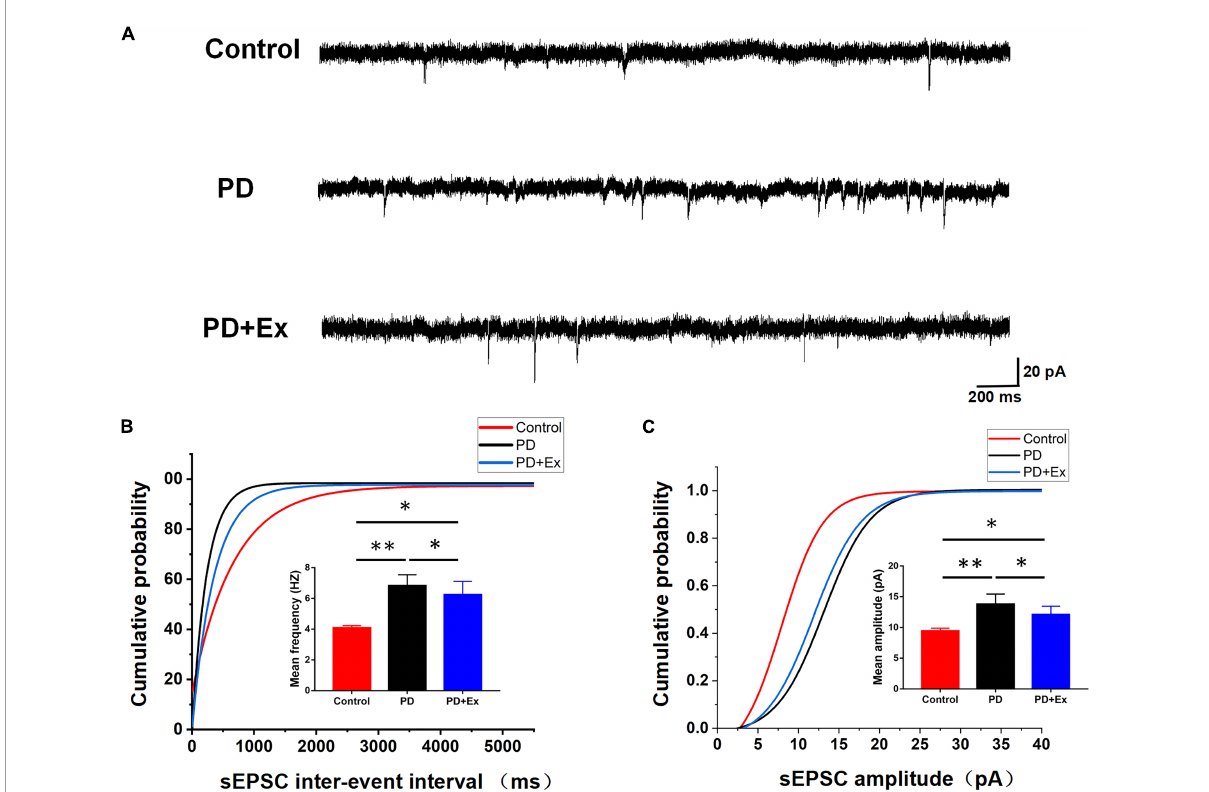
FIGURE5 Effect of exercise on D2-MSNs sEPSC in PD mice. (A) Sample traces of sEPSCs recorded in D2-MSNs. (B) Cumulative distributions of inter-event interval and bar charts showed sEPSC frequency (Kolmogorov–Smirnov test and one-way ANOVA, respectively, p < 0.05). (C) Cumulative distributions of amplitude and bar charts showed sEPSC amplitude (Kolmogorov–Smirnov test and one-way ANOVA, respectively, p < 0.05. A total of 1,275 events for the Control group, 2,106 events for PD group and 1,896 events for PD + Ex group were plotted in Cumulative distributions). All data are showed as mean ± SEM. ∗ p < 0.05, ∗∗ p <